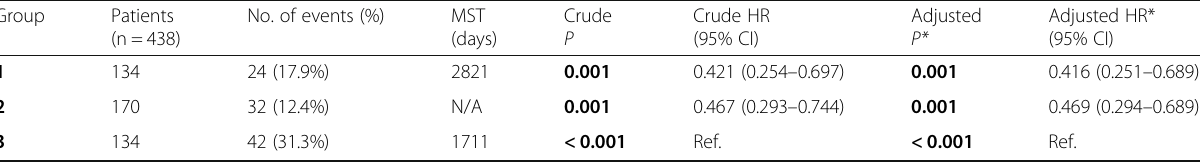
Table 3 Joint-effects analysis of the prognostic value of combinations of GSTM1 and GSTM2 Group Patients No. of events (n = 438)